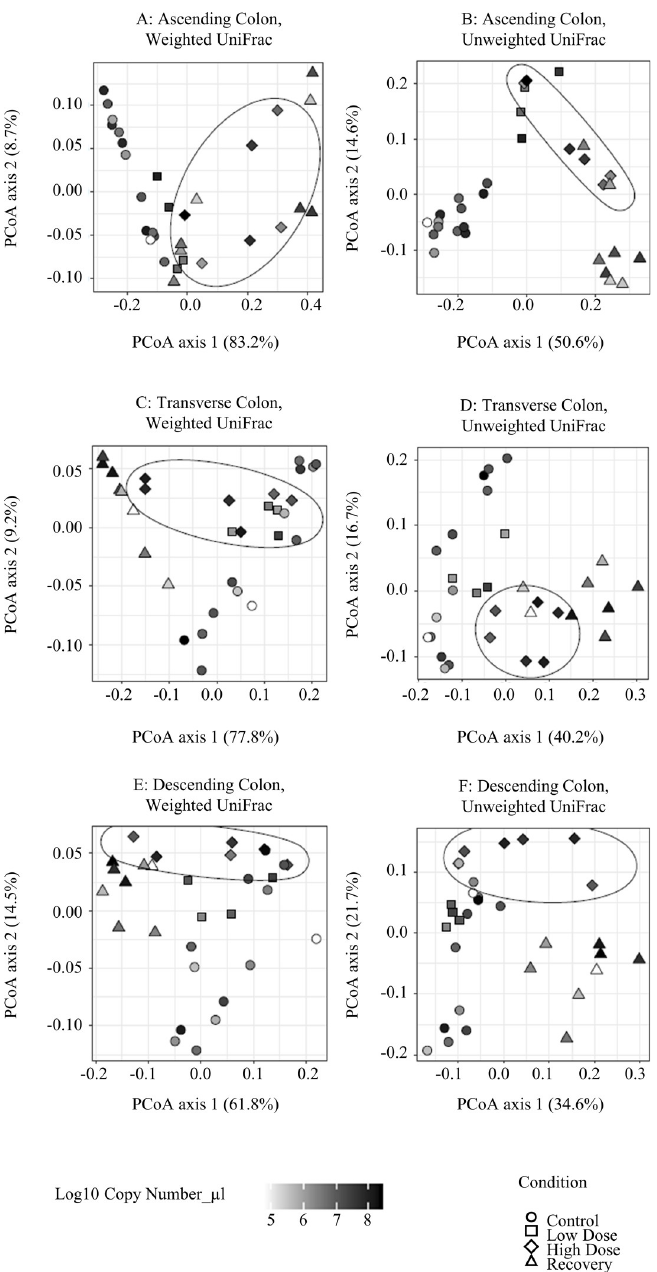
Fig 3. Beta diversity of mucosal phase combined with copy number (qPCR). A) Weighted UniFrac, ascending colon. B) Unweighted Unifrac, ascending colon. C) Weighted Unifrac, transverse colon. D) Unweighted Unifrac, transverse colon. E) Weighted UniFrac, descending colon. F) Unweighted Unifrac, descending colon.